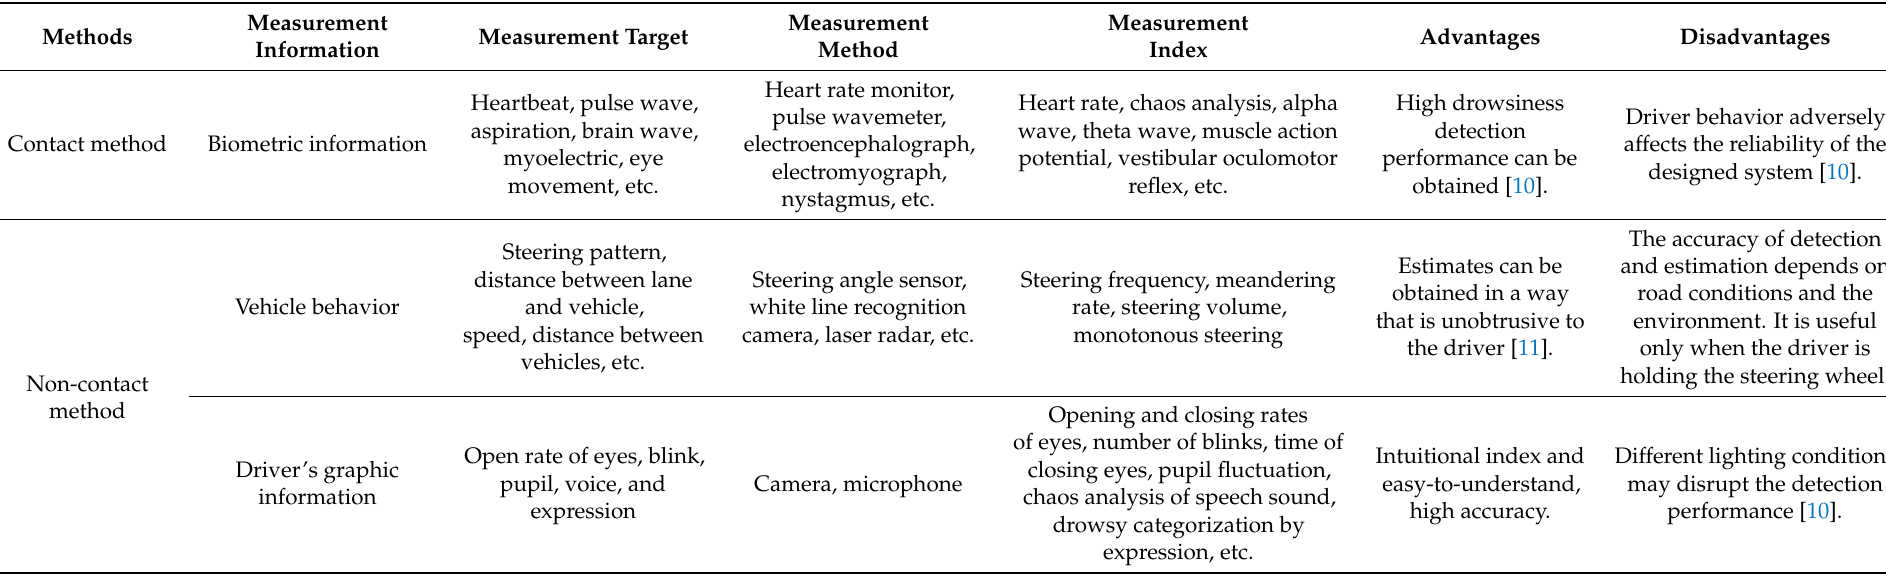
Table 1. Approaches for detecting driver’s